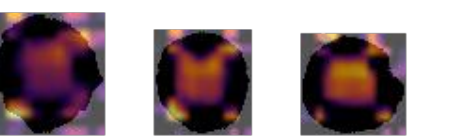
Figure 7. Type VI nodule corners and middle parts colorized by Grad-CAM.